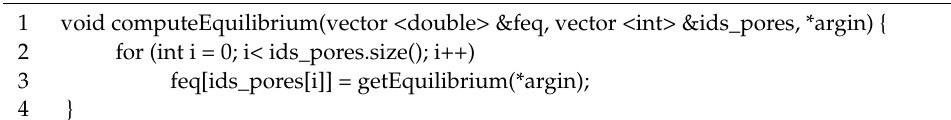
Algorithm 4. Local operation with direct